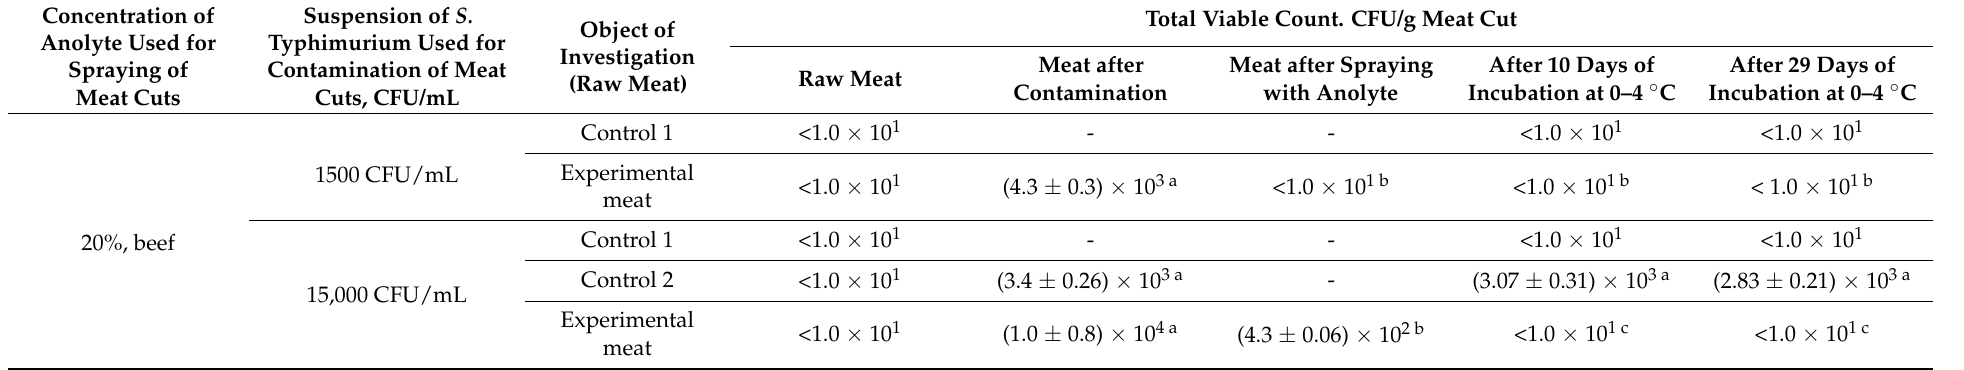
Table 4. The effect of anolyte’s concentration on the S. Typhimurium count of meat cuts contaminated with S. Typhimurium. Concentration of Suspension of Anolyte Used for Spraying of Meat Cuts